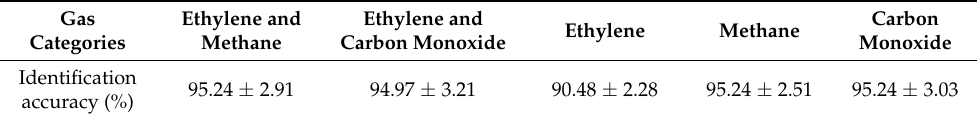
Table 7. Identification accuracy of WOA-LSTM for different gas components.